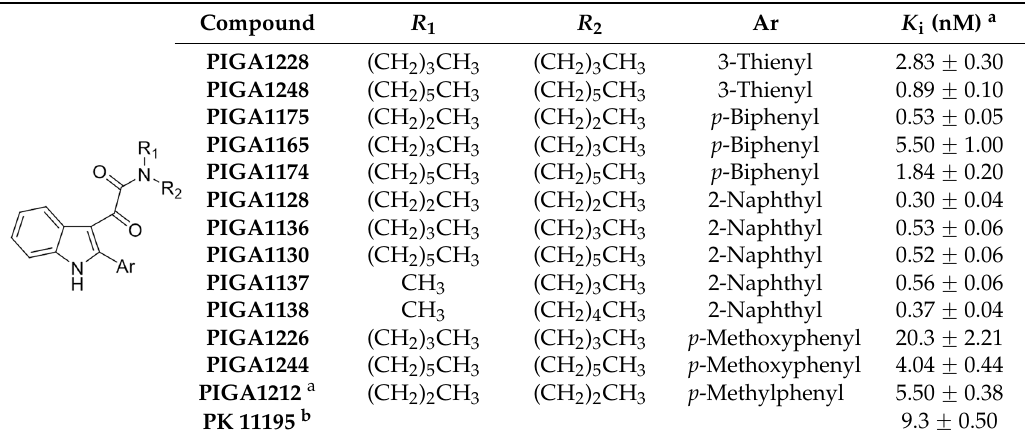
Table 1. TSPO binding affinity of the compounds. The concentration of the tested compounds that inhibited [ 3 H]PK11195 binding to rat kidney mitochondrial membranes (IC 50 ) by 50% was determined using six concentrations of the displacers, each performed in triplicate. The K i values are the means ± SEM of three determinations.